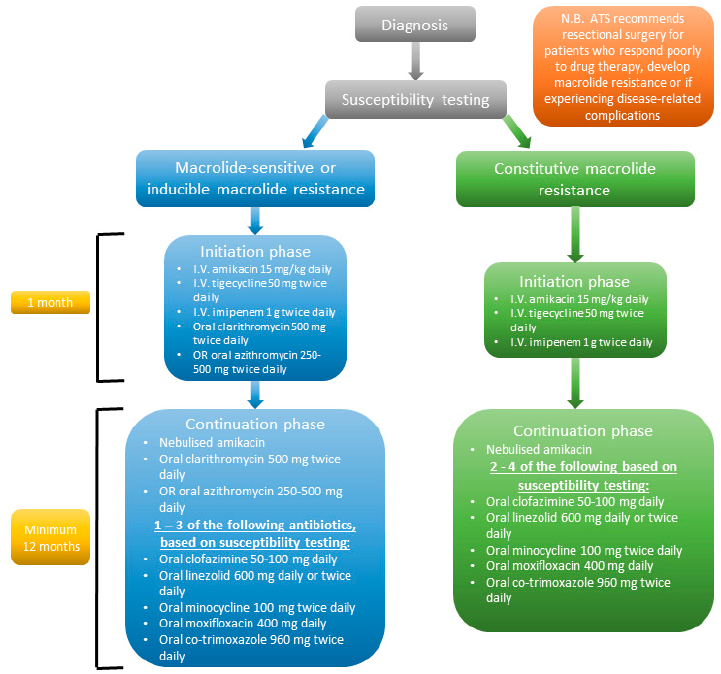
Figure 2. Flow chart showing treatment regimen for M. abs ‐ pulmonary disease based on